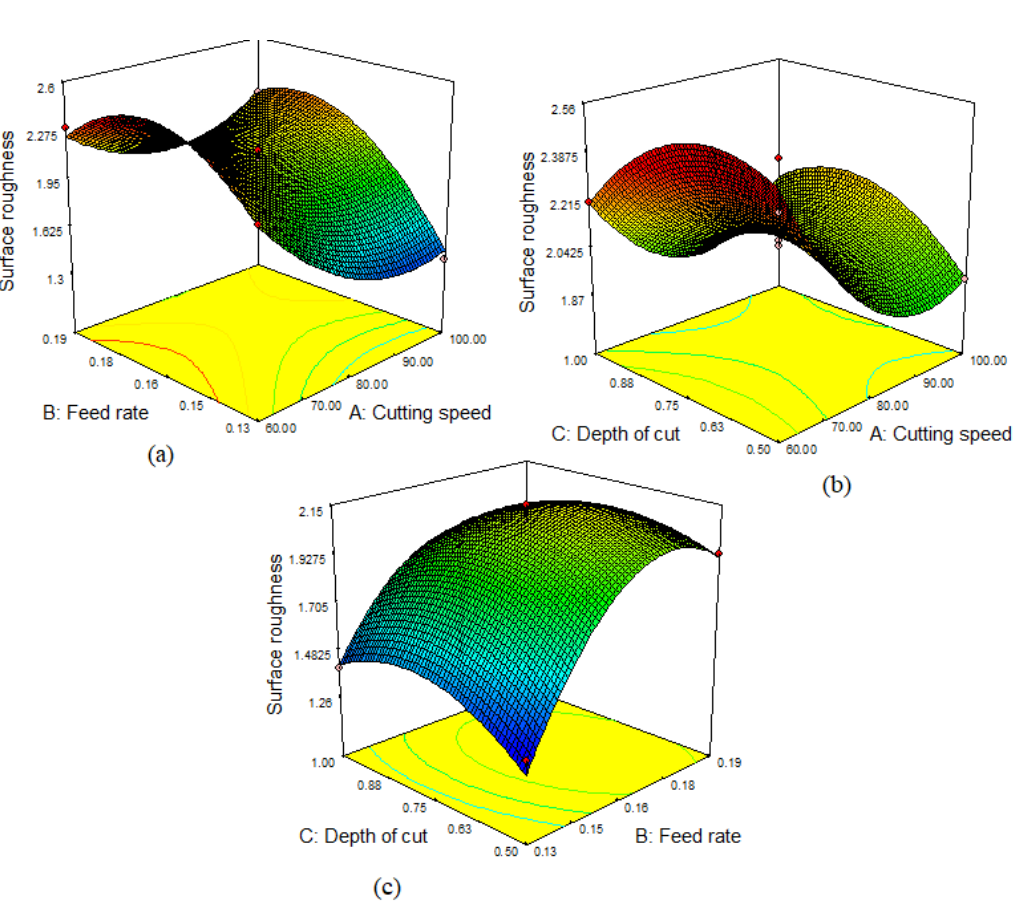
Figure 8. (a-c) esteemed response surface plot for surface roughness (R a